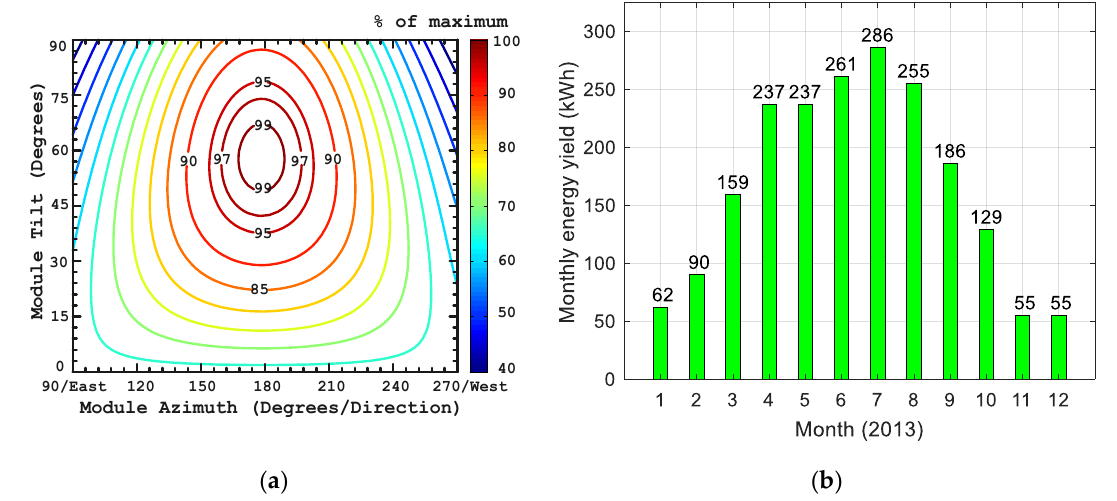
Figure 5. ( a ) PV system yield (% of maximum) for different orientations considering December month. ( b ) The estimated monthly energy yield of 2.6 kW PV system tilted at 51° and facing south.